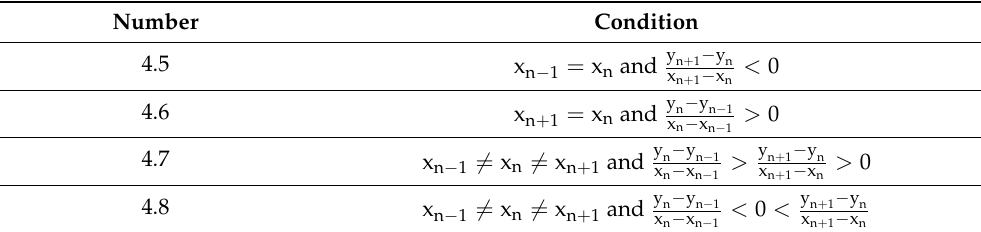
Table 2. Second conditions for detection based on